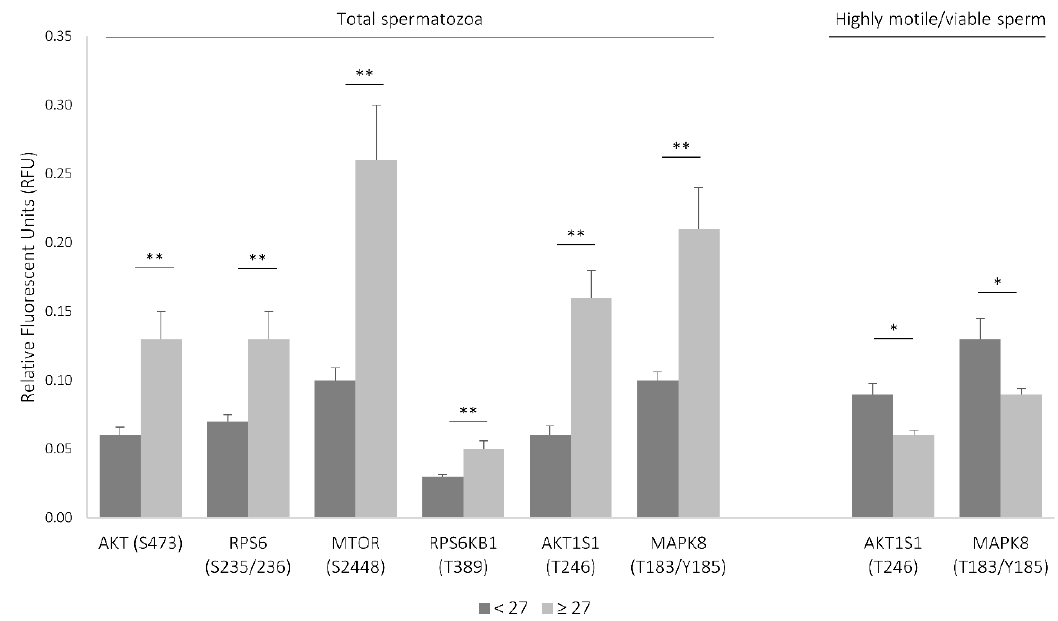
Figure 1. Signaling proteins associated with the mechanistic target of rapamycin (MTOR) pathway di ff erentially activated between groups aged ≤ 27 and aged > 27. Results are expressed as mean ± SEM. The difference between groups was assessed by Mann–Whitney U test. * Difference is significant at the 0.05 level (two-tailed); ** difference is significant at the 0.01 level (two-tailed).